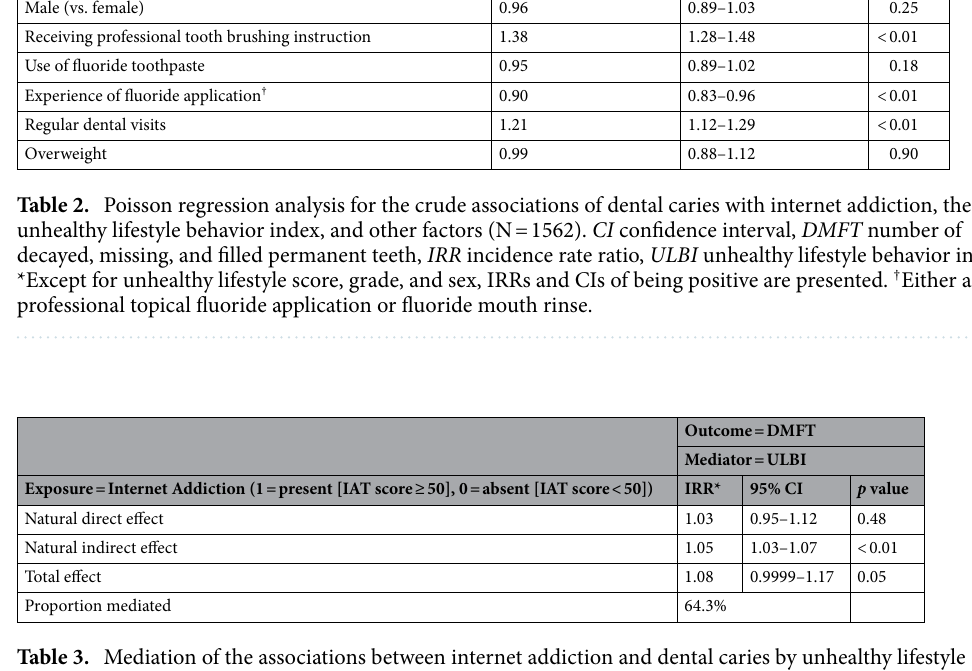
Table 3. Mediation of the associations between internet addiction and dental caries by unhealthy lifestyle behaviors (N = 1562). CI confidence interval, DMFT number of decayed, missing, and filled permanent teeth, IAT Young’s Internet Addiction Test, IRR incidence rate ratio, ULBI unhealthy lifestyle behavior index. *Adjusted for grade, sex, receiving professional tooth brushing instruction, use of fluoride toothpaste, fluoride application, regular dental visits, and